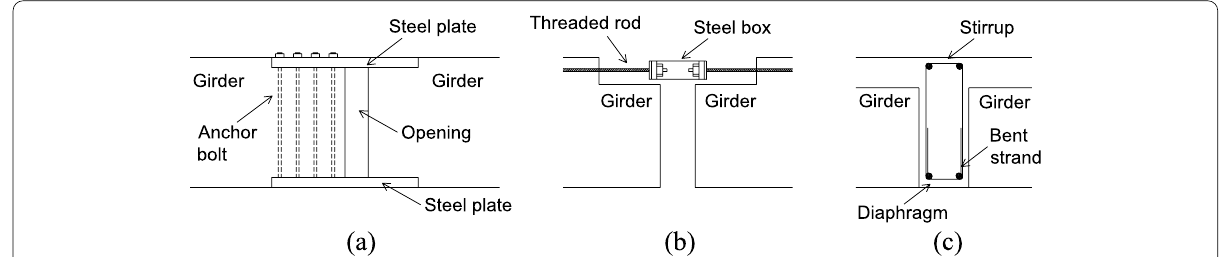
Fig. 4 Splice methods for continuity of pretensioned girders (reproduced from Bishop [39]; Sun [40]; Miller et al. [41]): a bolted plates; b threaded rods; c positive moment